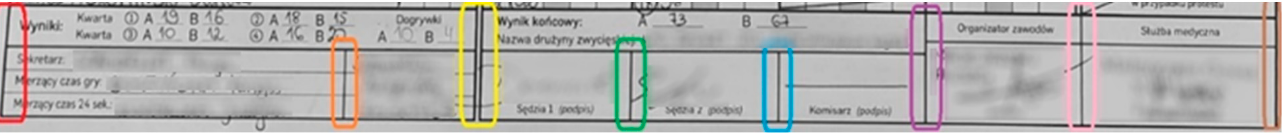
Figure 2. Bottom of the protocol with vertical lines